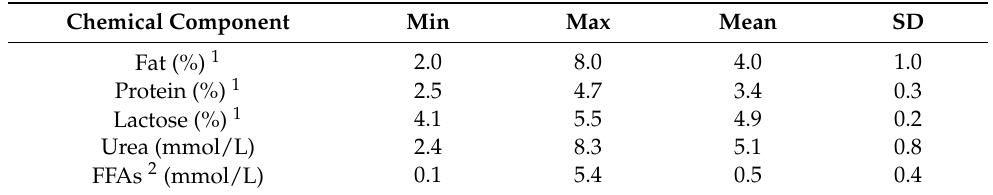
Table 2. Minimum, maximum, mean and standard deviation (SD) of parameters measured for 2143 milk samples from 61 cows